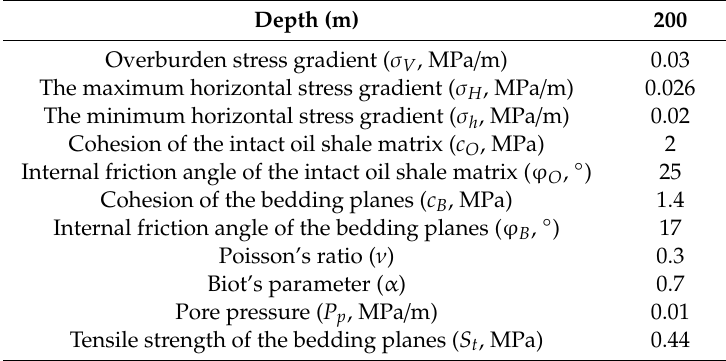
Table 1. Physical and mechanical properties of Nong’an oil